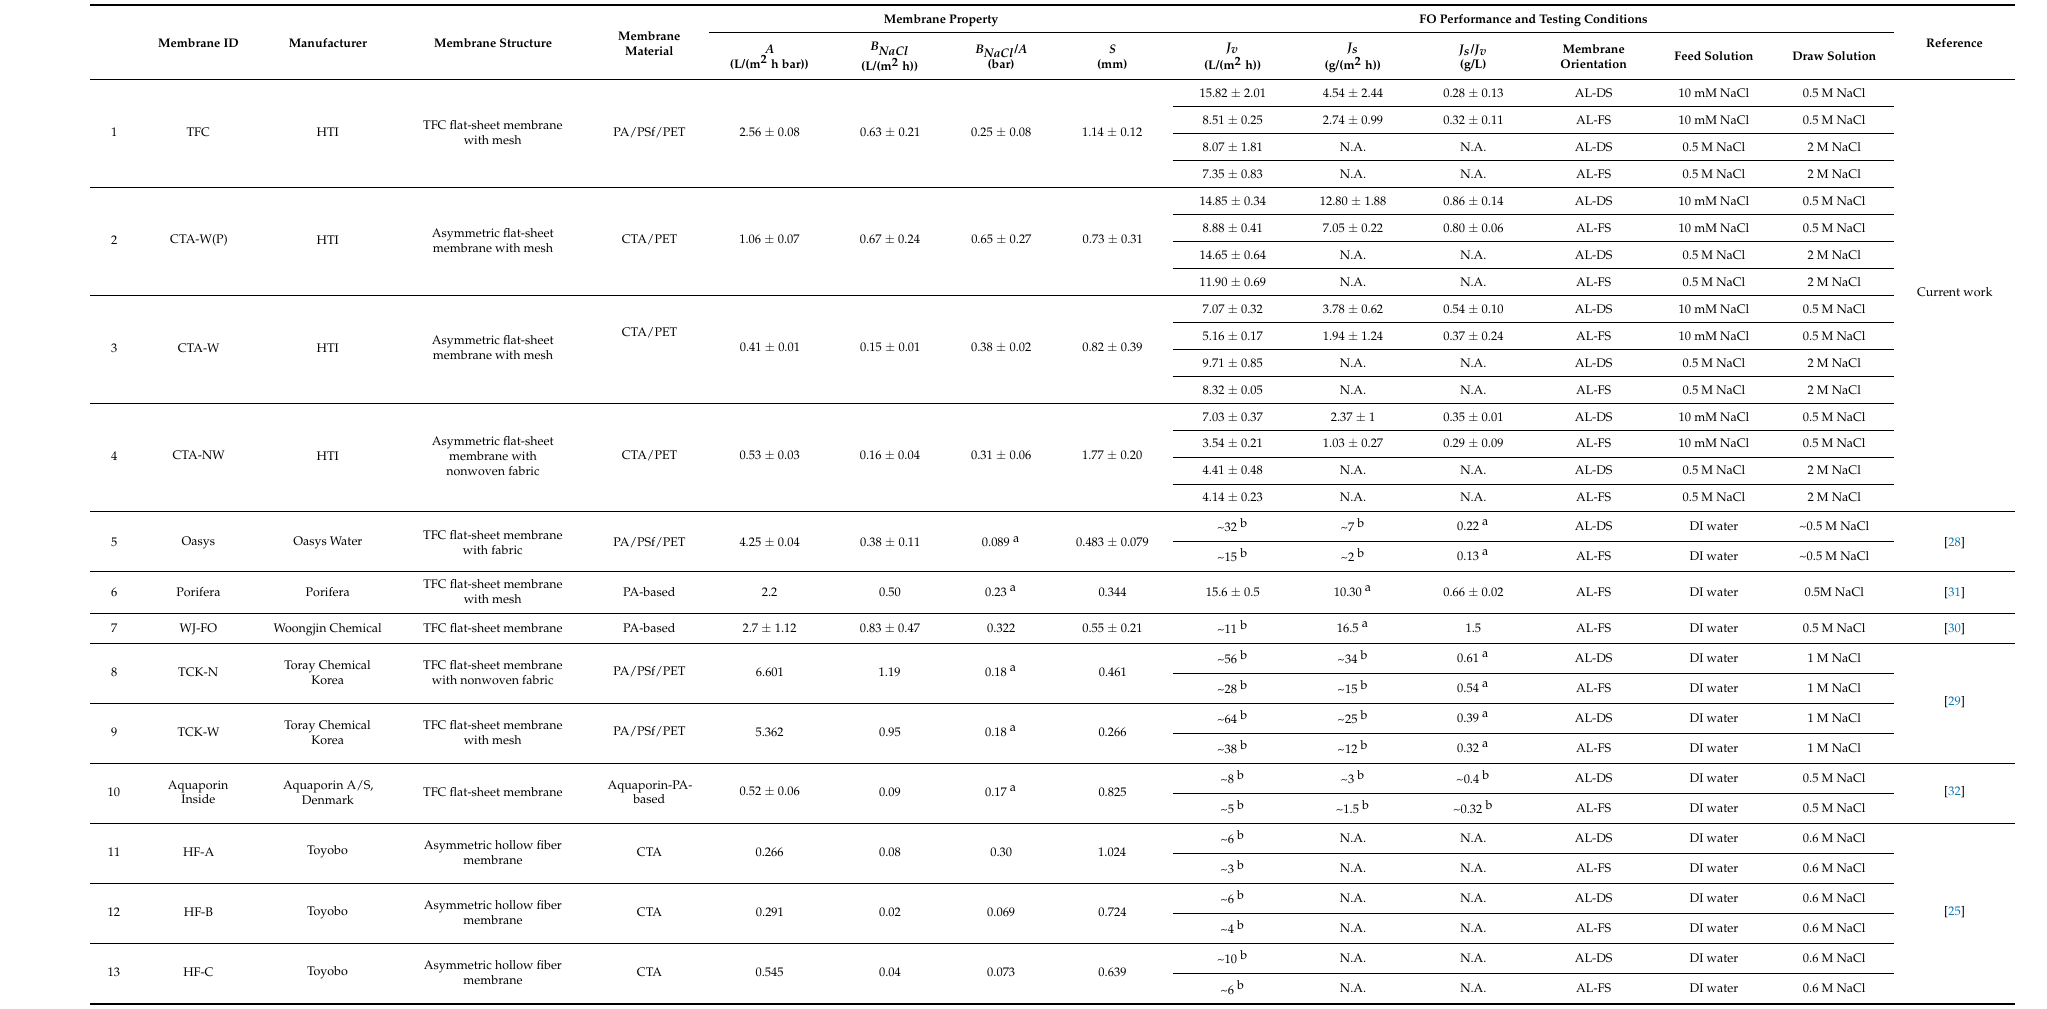
Table A1. Property and FO performance of commercial